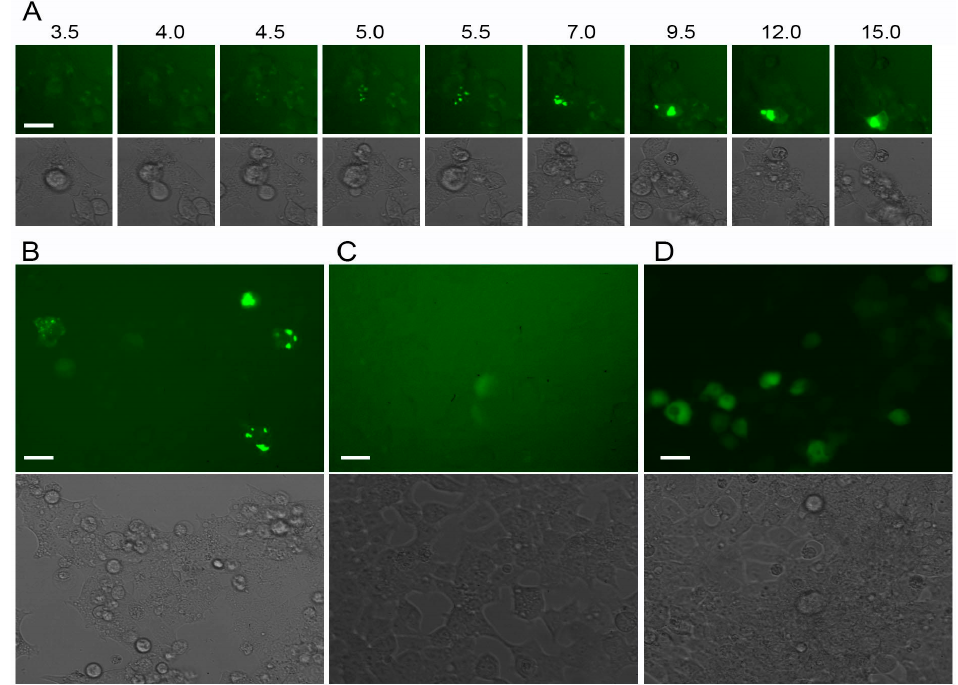
Figure 13. Expression of fluorescent proteins Trio-AG4 or mNeonGreen under control of H1 promoter in HEK293T cells. ( A ) Time-lapse microscopy of cell expressing Trio-AG4. Numbers above the images designate time (in hours) post transfection. Note that fluorescent spots can be reliably detected 4 h post transfection; ( B ) cells expressing Trio-AG4 15 h post transfection; ( C , D ) cells expressing mNeonGreen 15 h ( C ) and 72 h ( D ) post transfection. In each panel, upper images—green fluorescence, bottom images—corresponding transmitted light photos. In ( A ), fluorescence images were taken under the same settings; in ( B – D )—under different settings. Scale bars, − 30 µm.